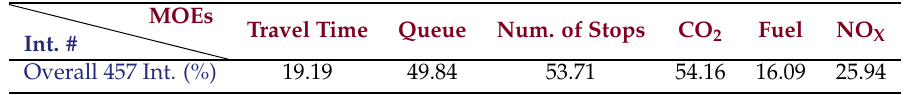
Table 11. Average (%) improvements of MOEs using DNB over PSC controller (10% Demand) over the links directly associated with